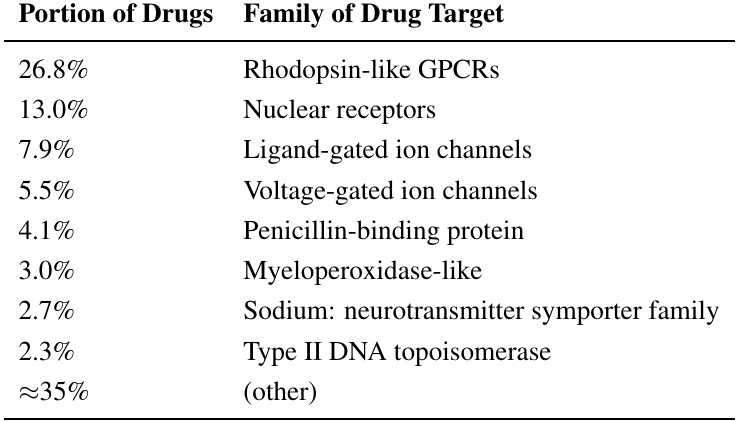
Table 1. The percent distribution of the gene families targeted by FDA-approved drugs as of 2005. These statistics were compiled by Overington et al. from FDA data in 2005